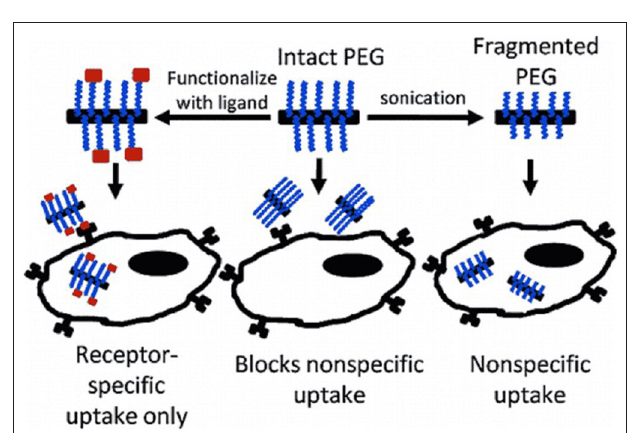
FIGURE 2 | Ultrasonic dispersion of SWCNTs with PL-PEG.